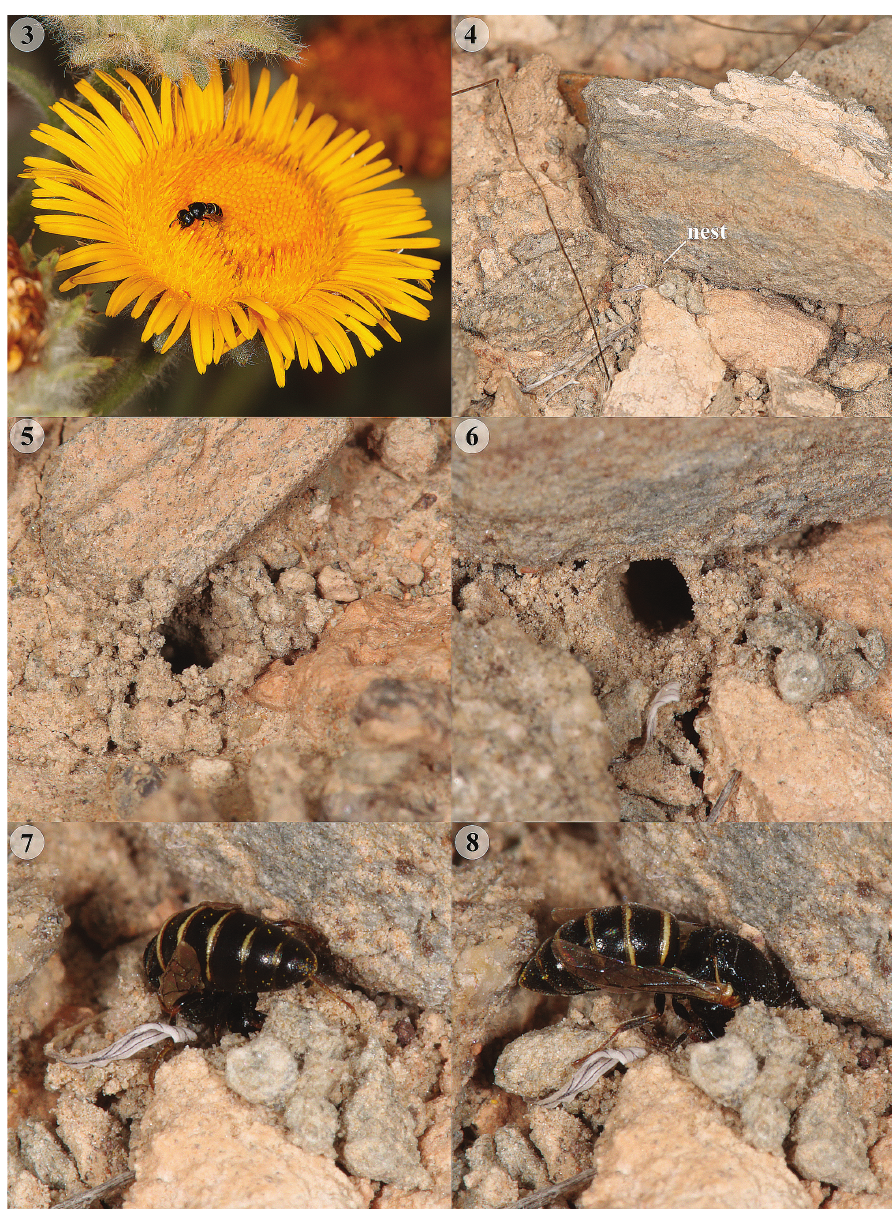
The proterandric disc florets open from the outer ones inwards. The mouthparts of the female are situated in the zone where disc florets are in an early male phase of anthesis 4 Location of nest CH of Q. major at locality I 5 Nest entrance of nest GB (viewed at an angle) 6 Nest entrance of nest CH (viewed from above) 7 Female of nest CH partly backed out of the turret moving slightly around her longitudinal axis with her mouthparts orientated towards the inner surface of the turret wall 8 Female of nest CH backing out of the nest carrying a load of soil particles with her mouthparts (visible between fore and mid